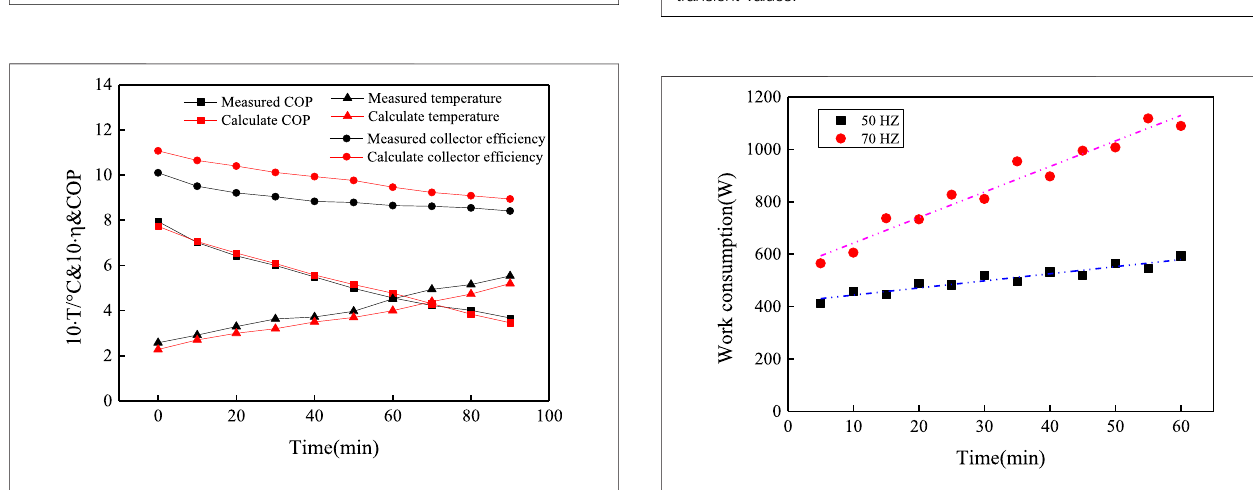
FIGURE 3 | Experimental simulation comparison of system COP transient values.